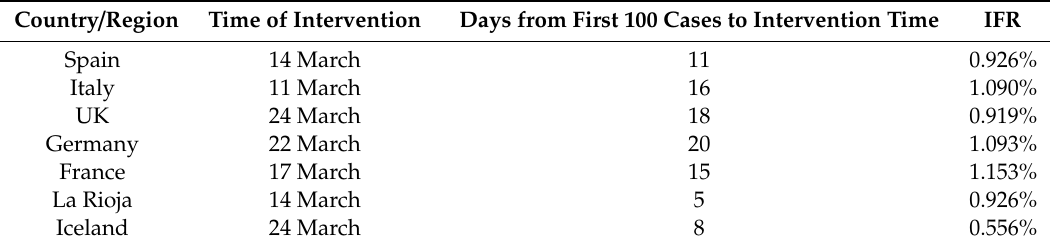
Table 2. Model parameters (intervention dates and IFR) used in this work. Country / Region Time of Intervention Days from First 100 Cases to Intervention